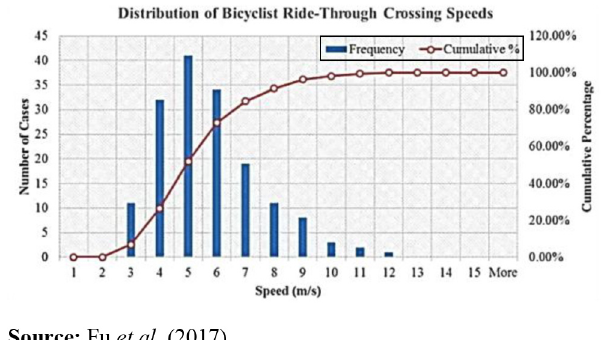
Figure 11 Distribution of speed limits for crashes